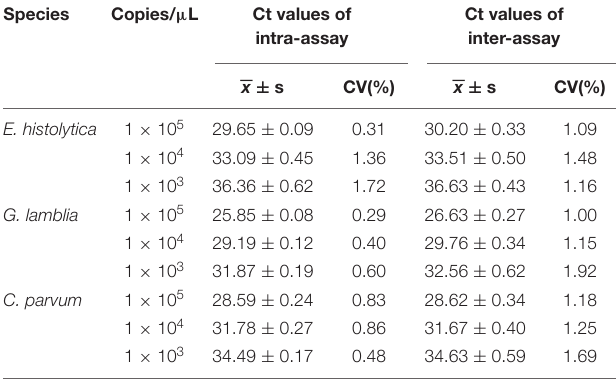
TABLE 4 | Repeatability analysis of triplex quantitative PCR (qPCR). Species Copies/ µ L Ct values of